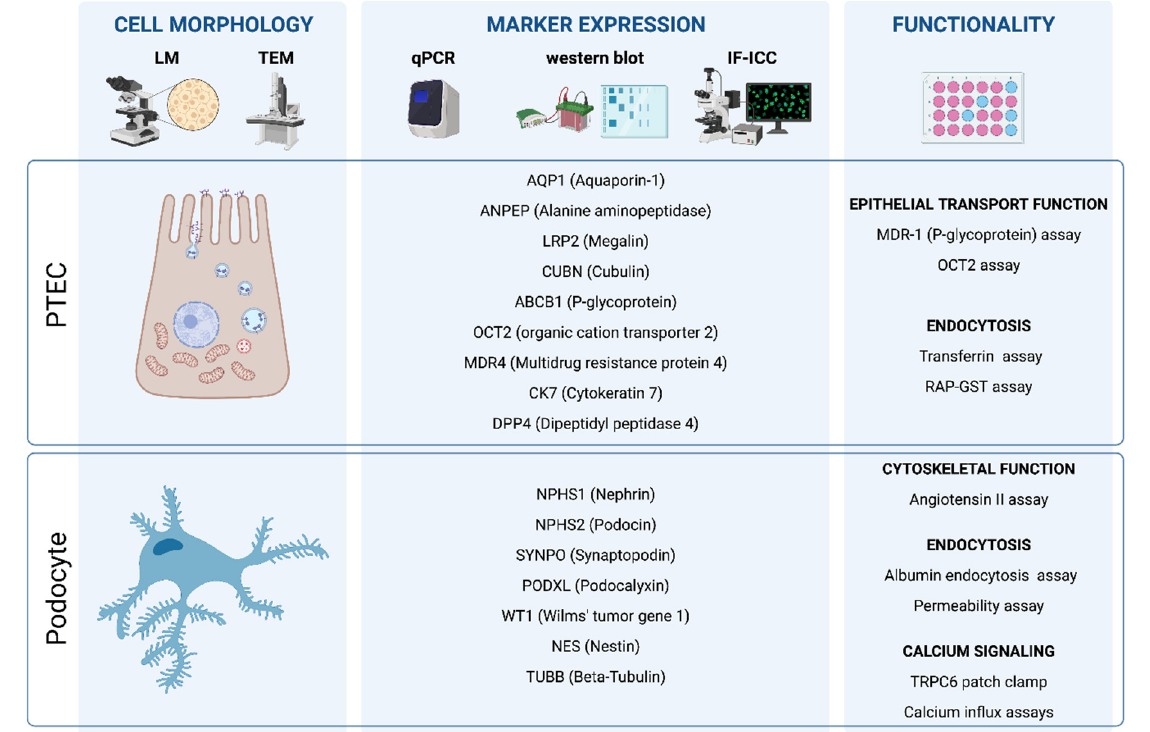
Figure 4. Technology toolbox for characterization of urine-derived kidney epithelial cells. Urine-derived kidney epithelial cells are characterized based on their cellular morphology, the expression of cell-type specific markers, and their functionality via cell-specific assays. To this end, microscopy, including light microscopy (LM) and transmission electron microscopy (TEM), qPCR and Western Blot plus immunocytochemistry are useful technologies.